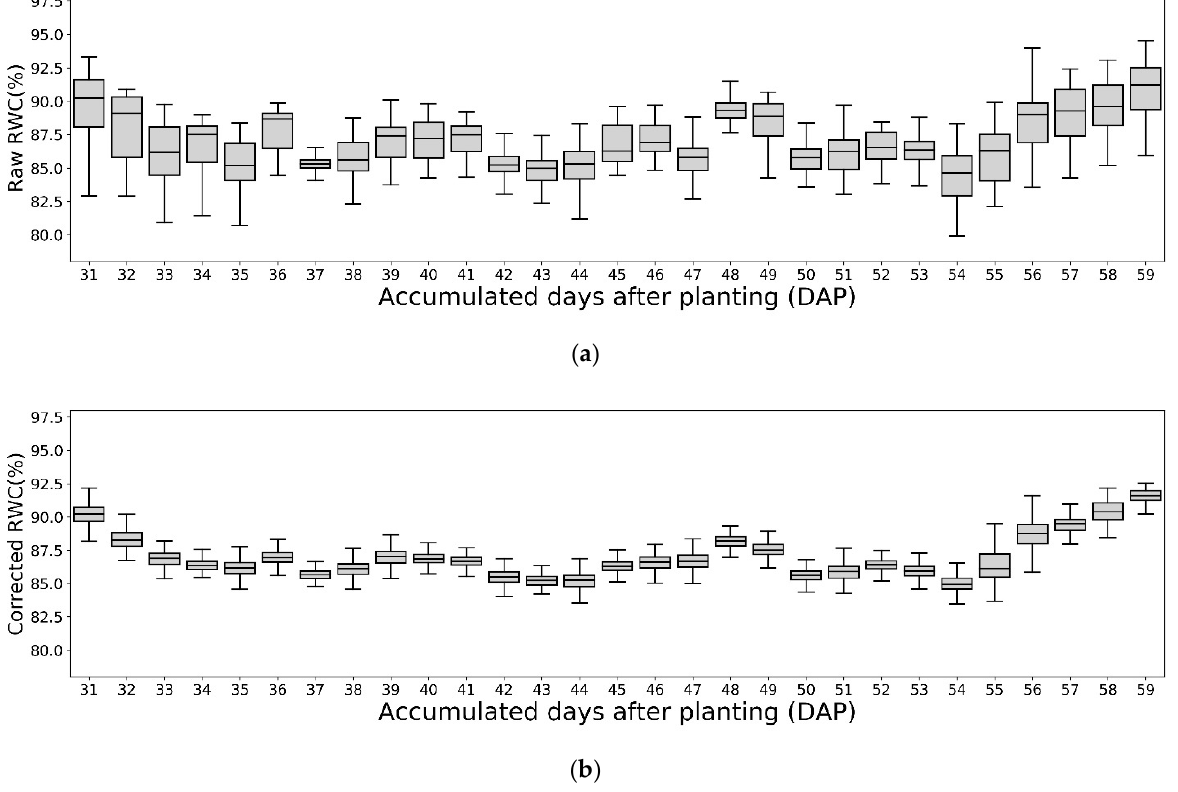
Figure 10. Box plots for the five-fold cross-validated correction result of sample dataset (G1H). ( a ) The raw predicted RWC showed huge daily variances across 31 days. ( b ) The ANN model corrected predicted RWC has much more condensed boxes.